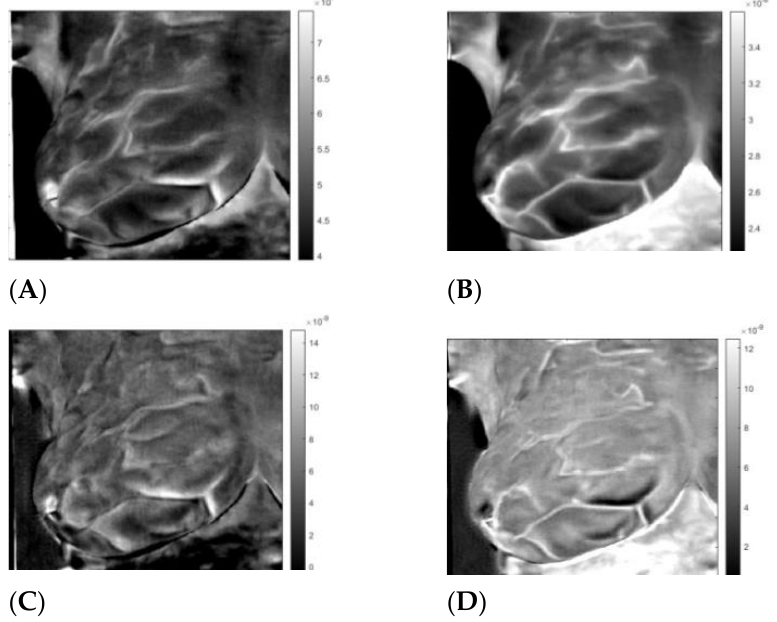
Figure 6. Healthy right breast of patient “T281.” Images 1A to 1D after application of the inverse ICA transform. ( A , B ) are images of thermal reflection, while ( C , D ) are images of vasoconstriction. By applying the inverse transformation to images 3-1 to 3-4, we get the images in Figure 6. In Figure 7, we present the result for the left breast, labeled “sick”; for patient #T285 in Figure 8(1–4) for the left breast, labeled “healthy”; and for the right breast, labeled and #286. Results for all the four patient are posted in the Supplemental